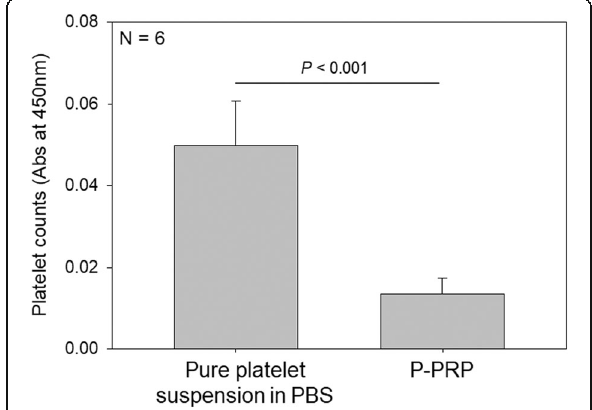
Fig. 3 Quantitative spectrophotometric determination of platelet counts on the surface of cp -Ti